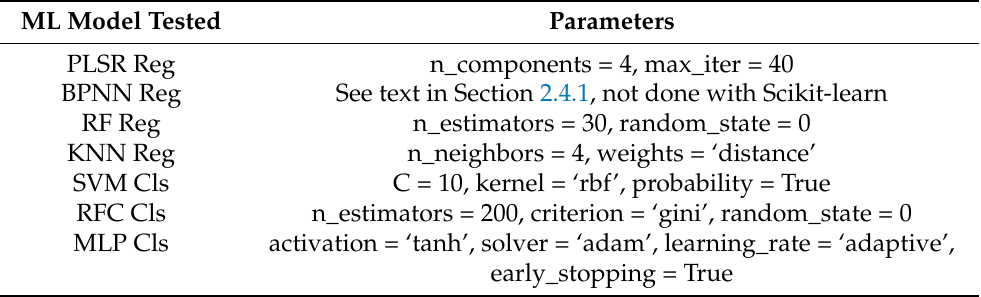
Table 1. Optimized regression (Reg) and classification (Cls) machine learning algorithm parameters in Python scikit-learn. If a parameter is not explicitly mentioned, it was left to default Scikit-learn definitions. Refer to the Abbreviations section at the end of the paper for full model names.